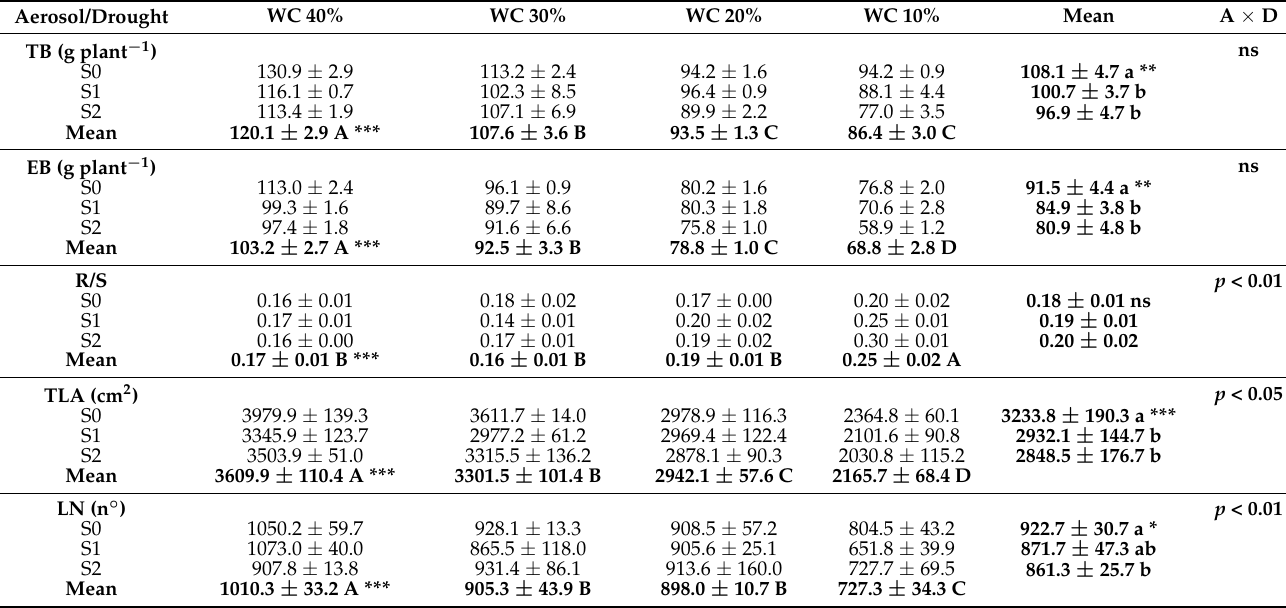
S1: 50% Synthetic seawater solution, S2: 100% Synthetic seawater solution. Data are means ± standard error ( n = 3). Three biological replicates were used for the measurements. TB = Total dry biomass; EB = Epigeous dry biomass; R/S = Root to shoot ratio; TLA = Total leaf area; LN = Leaf